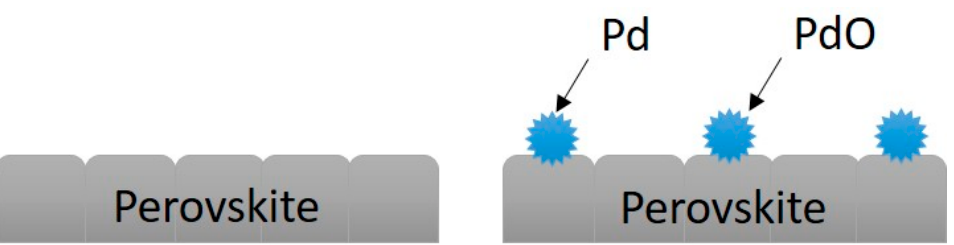
Figure 10. Pd addition increased the surface area of the catalyst: spherical Pd particles protruded on the perovskite layer and thus increased surface area of the catalyst.